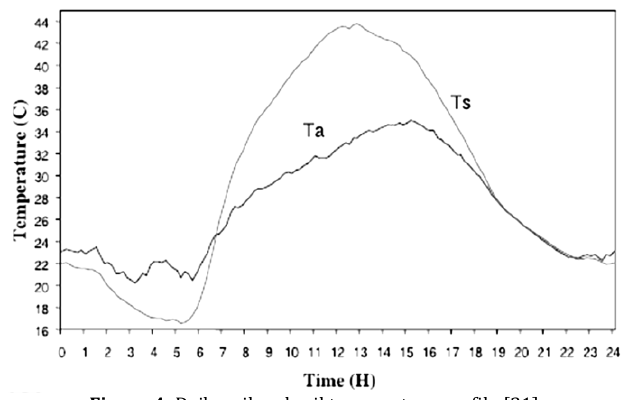
Figure 4: Daily soil and soil temperature profile [31]